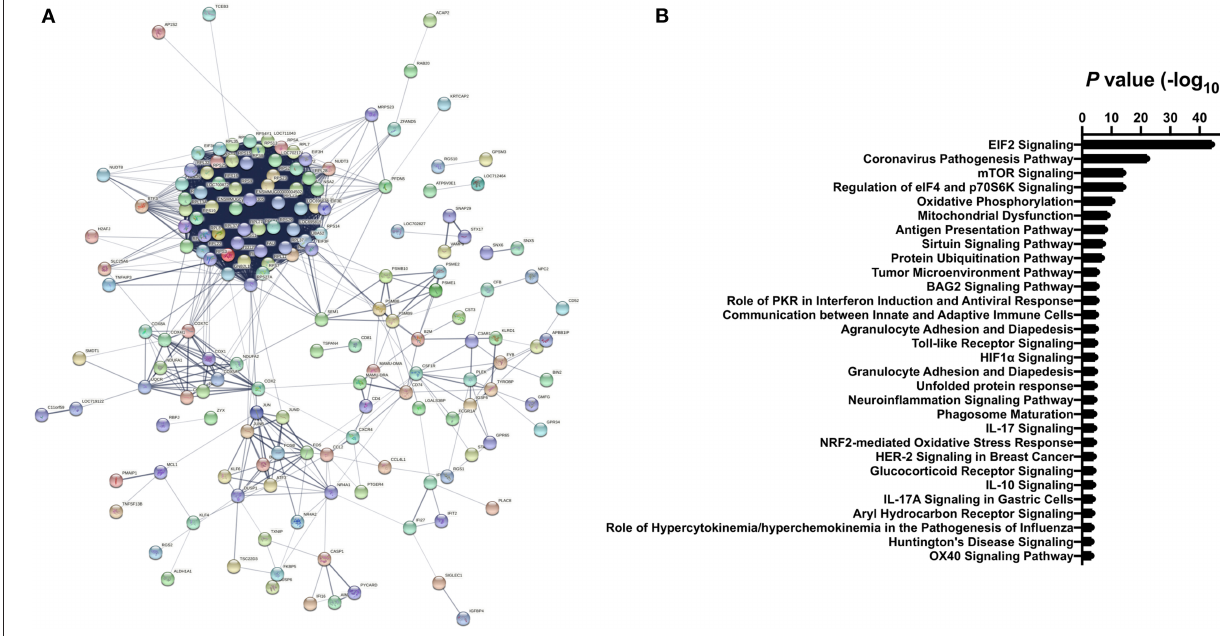
FIGURE 3 | Differential gene expression analysis of CD14 + villous cells (A) STRING analysis of significant differentially expressed genes from ZIKV infected vs. uninfected clusters. Lines with different colors represent the existence of different types of evidence applied to predict associates between proteins. (B) The top Gene Ontology (GO) terms from differentially expressed genes represented as -log 10 ( P value). Differentially expressed genes between ZIKV infected and uninfected clusters were identified using a Wilcoxon Rank Sum and filtered using adjusted p < 0.001 and average fold-change >